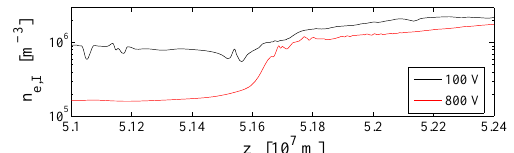
Figure 7. Density of the ionospheric electrons in the 100V sim- ulation at t = 215 . 5s (black line) and in the 800V simulation at t = 138 . 5s (red line).